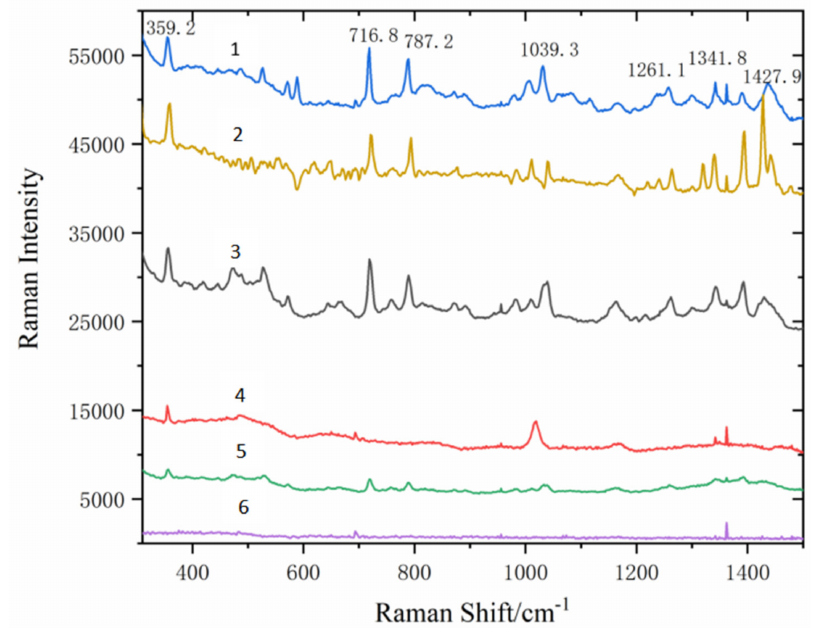
Figure 12. The detection limit of benzanthene captured on Fe 3 O 4 @PDA@Ag@GO nanocomposites SERS substrate (1) 10 − 4 g/L benzanthene standard solution; (2) benzanthene solid; (3) 10 − 5 g/L ben- zanthene standard solution; (4) 10 − 6 g/L benzanthene standard solution; (5) 10 − 7 g/L benzanthene standard solution; (6) 10 − 8 g/L benzanthene standard